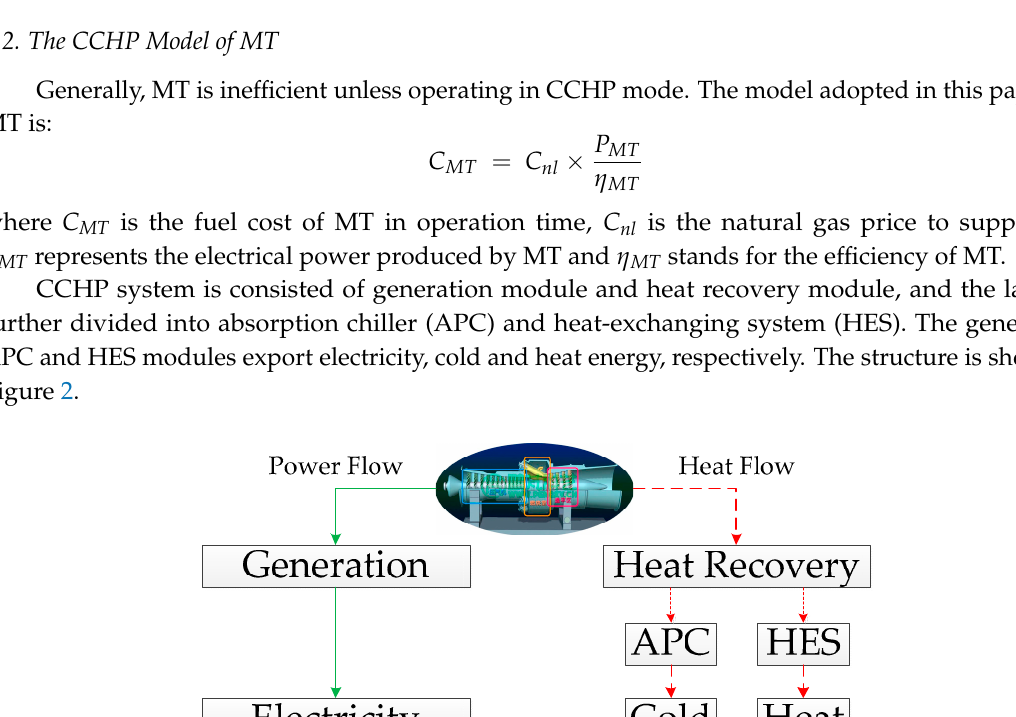
Figure 1. Typical structure of a microgrid (MG). PCC: point of common coupling.